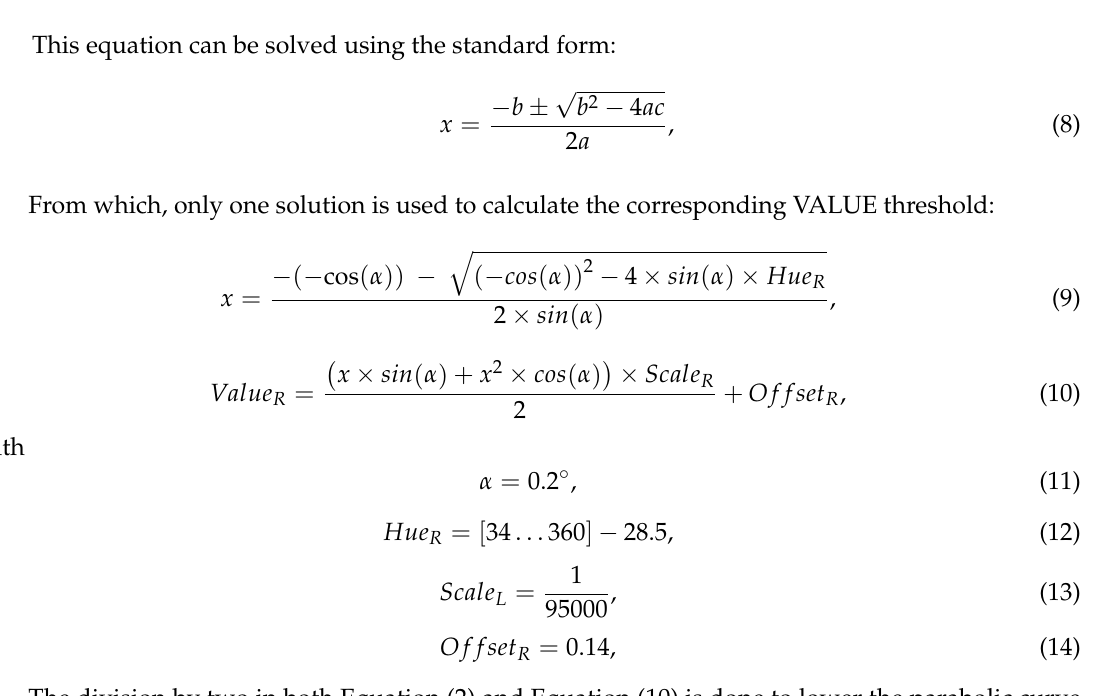
i.e., blue for WSR = 0.95 to 1, cyan for WSR = 0.8 to 0.95 and magenta for WSR = 0.7 to 0.8. The other WSR ranges are not indicated as they would overrule the plot. The non-WB pixels, which are denoted as land, are indicated by the dark grey dot symbols. The refined thresholds allow the detection of WBs outside the fixed threshold levels as indicated by the blue arrow. Although the refined thresholds are tuned to detect as much WBs as possible, not all WBs can be detected because they are intermixed with land pixels as indicated by the red arrow. The 2D scatter plots of the eight first test areas are shown in Appendix B.